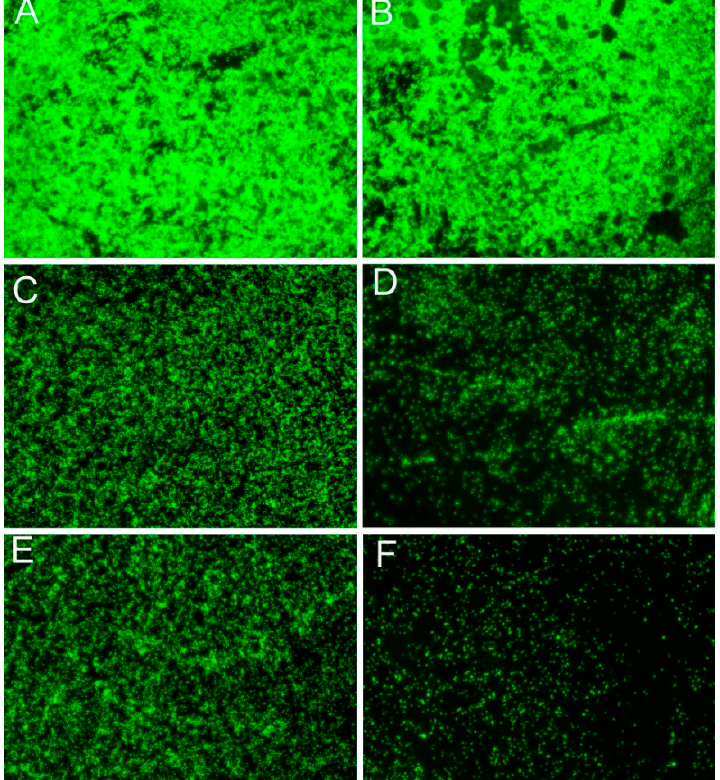
Figure 7. Fluorescence microscope images of biofilm formation of R. solanacearum cells after treatment with: ( A ) sterile water; ( B ) DMSO; ( C , D ) coumarin at final concentration of 64 μ g/mL and 128 μ g/mL respectively; and ( E , F ) carvacrol at final concentration of 64 μ g/mL and 128 μ g/mL, respectively. R. solanacearum were incubated with different treatment for 12 h at 30 °C without shaking, and exopolysaccharide matrixes were stained with FITC-ConA. Each treatment was repeated in triplicate.